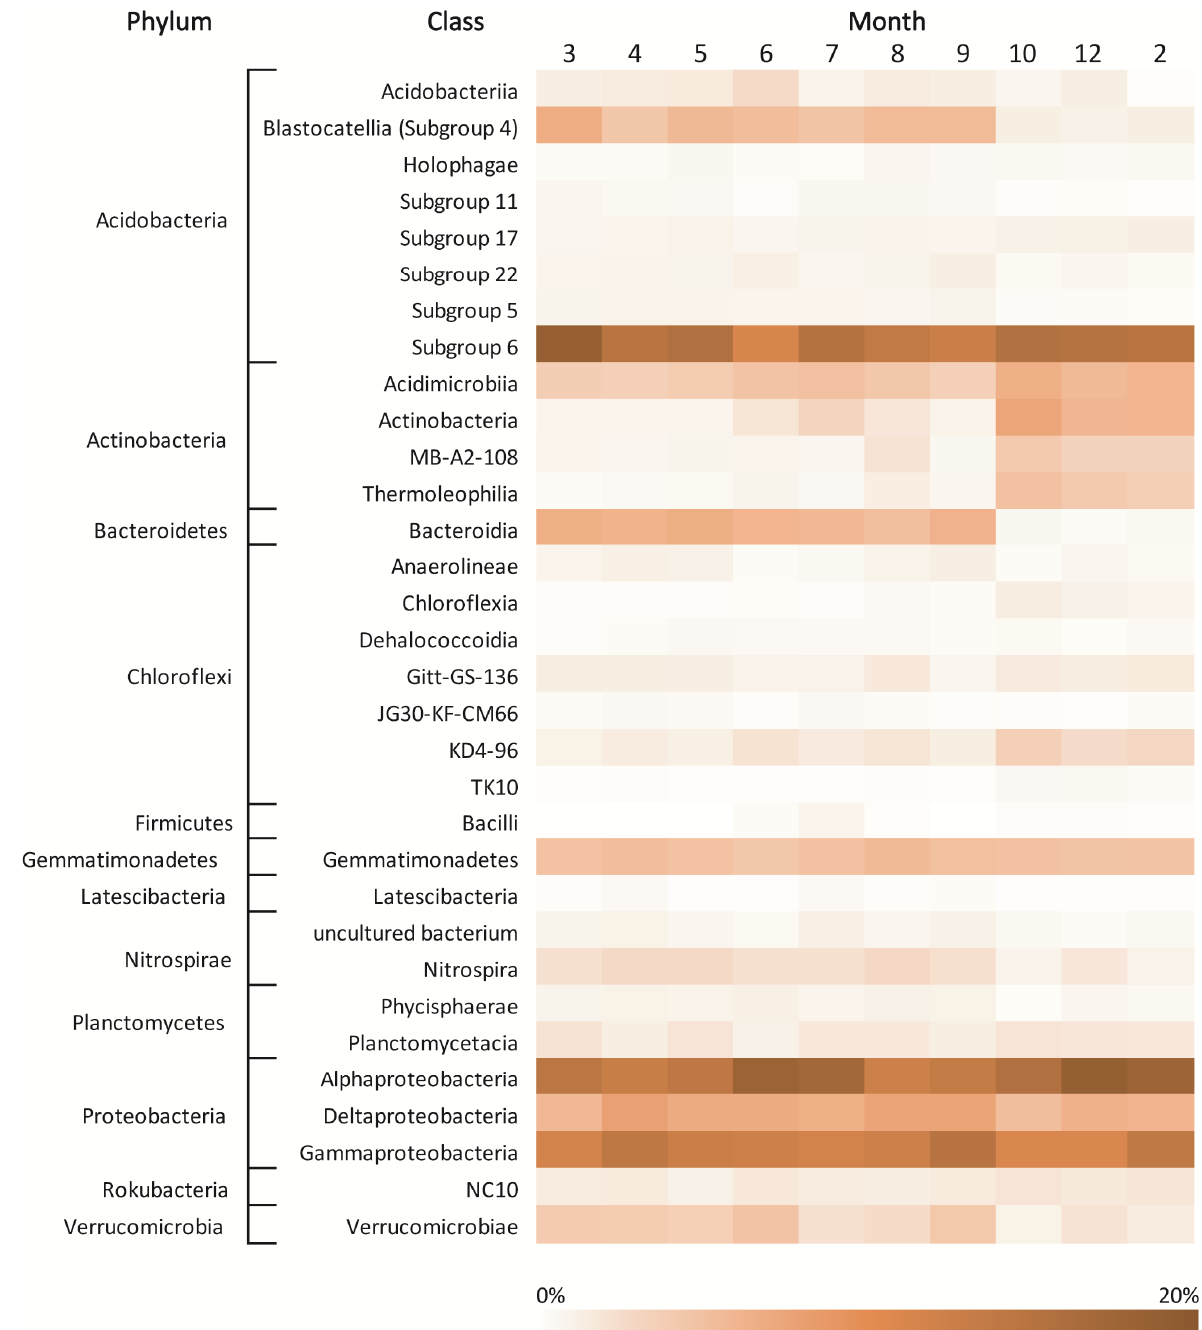
Figure 4. Relative abundances of different classes in total bacterial communities of the upper organic soil horizon throughout the